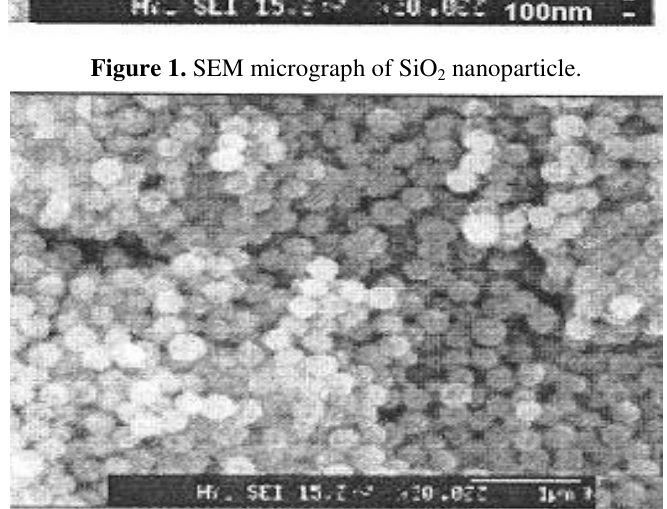
-APTES nanoparticles. 2